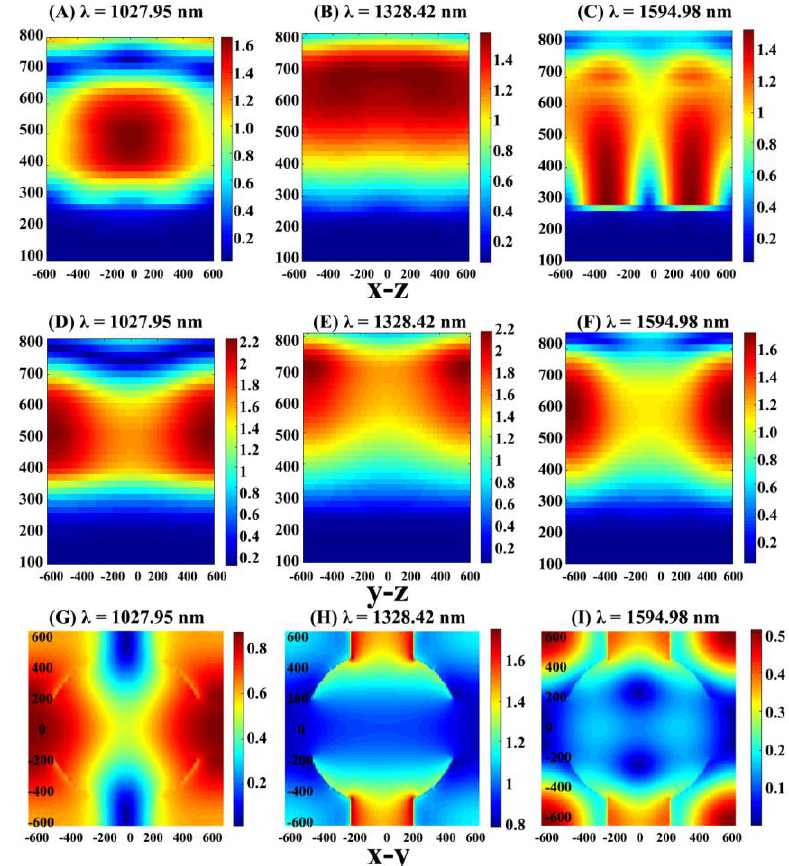
Figure 4. ( A – C ) are electric field maps at 1027.95 nm, 1328.42 nm, and 1594.95 nm, respectively. They are all x - z sectional views. ( D – F ) are three electric field maps at 1027.95 nm, 1328.42 nm, and 1594.95 nm, respectively. They are all cross-sectional views in the y - z direction. ( G – I ) are three electric field maps at 1027.95 nm, 1328.42 nm, and 1594.95 nm, respectively. They are all cross-sectional views in the y - z direction.